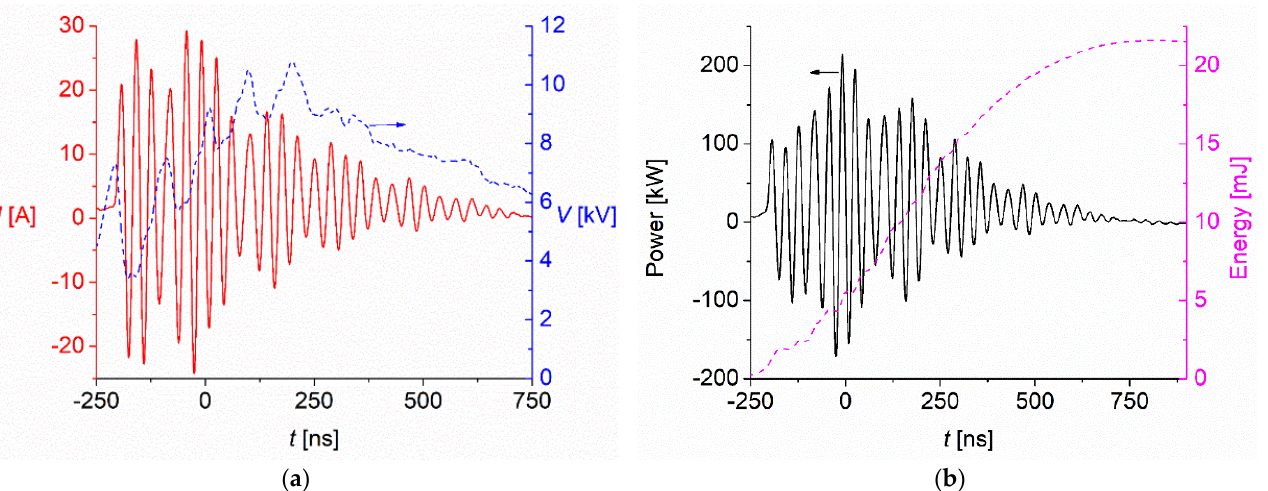
Figure 2. ( a ) Voltage and current pulse waveforms of the discharge (arrow indicates the voltage scale); ( b ) instantaneous power and energy dissipated in the discharge (arrow indicates the power scale).